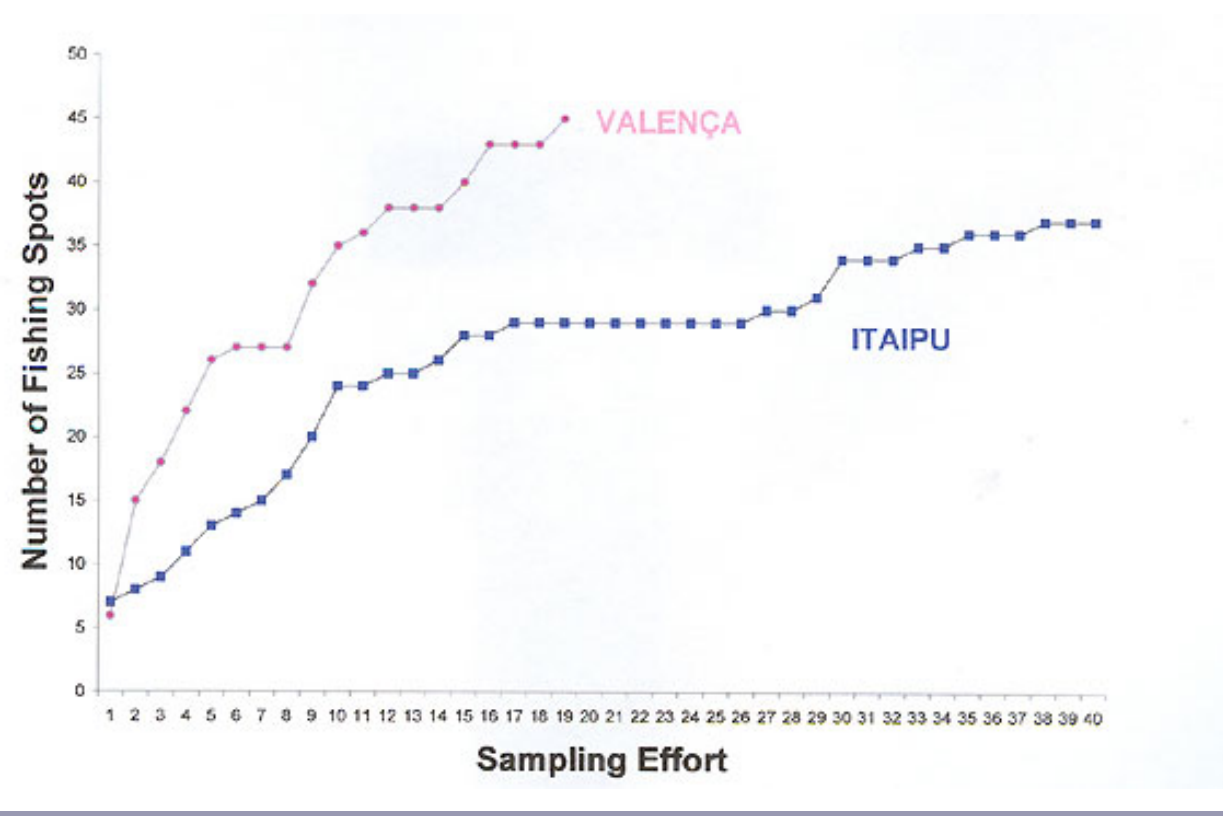
Fig. 3 . The cumulative number of new fishing spots given in interviews vs. sampling effort in Valença, Bahia State, and Itaipu, Niterói, Rio de Janeiro